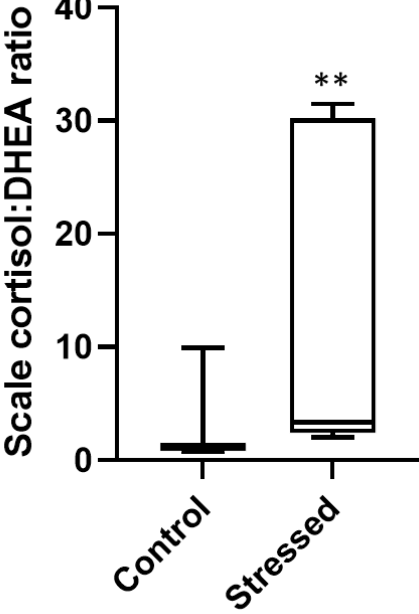
Figure 3. Scale cortisol:DHEA ratio in control and stressed goldfish presented as the median (middle